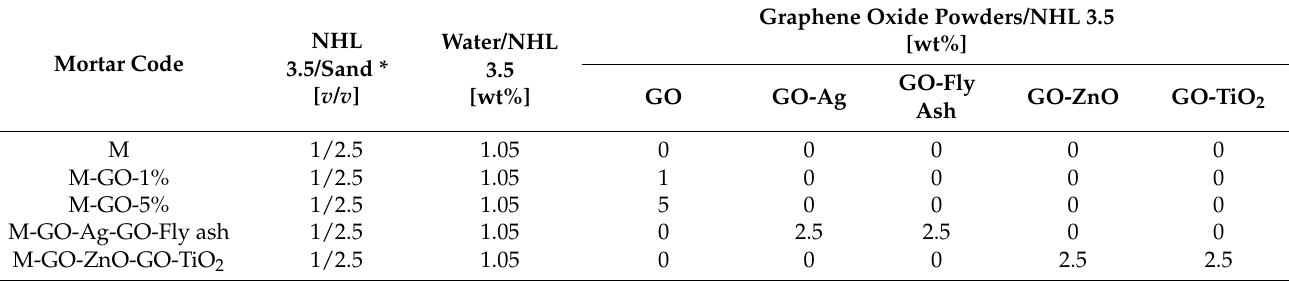
Table 1. The recipe for mortar